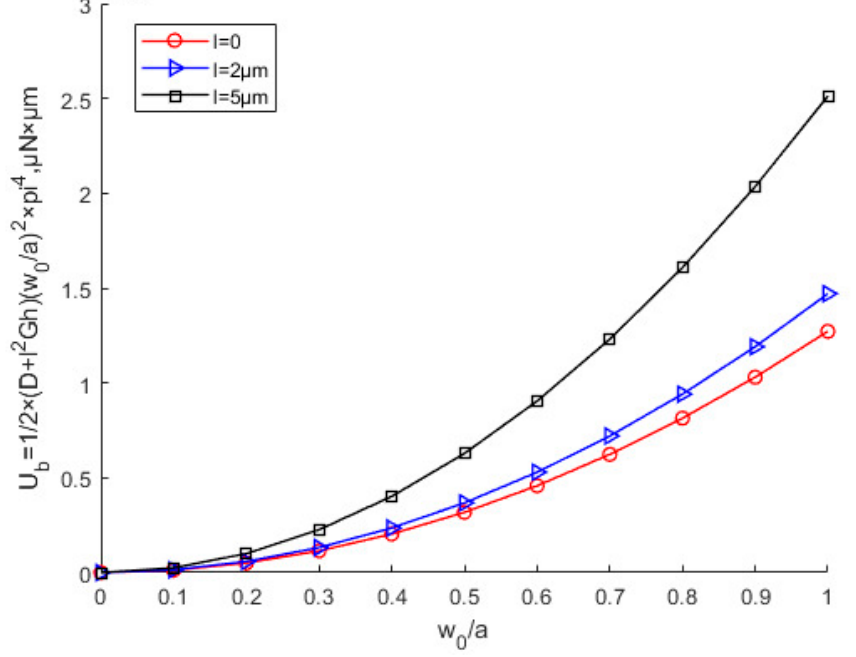
Figure 7. Effects of the scale parameters on buckling strain energy of a thin Cu plate.